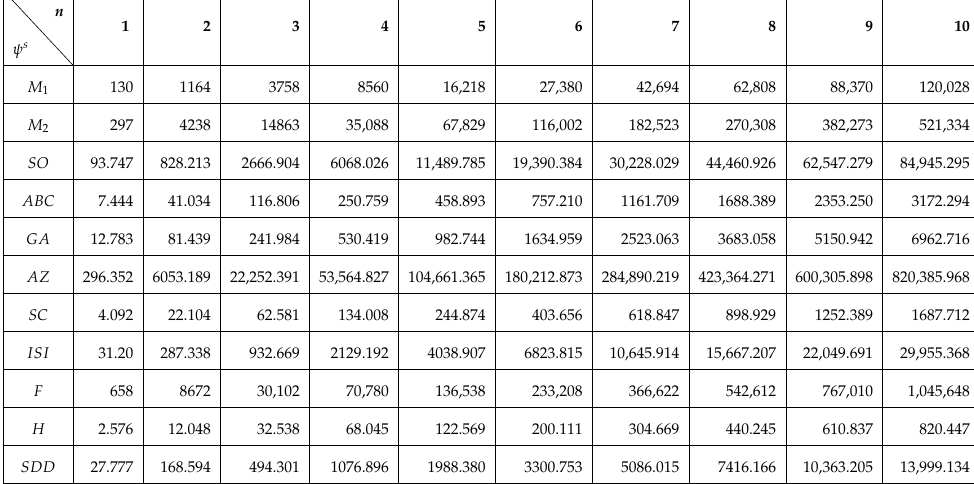
Table 7. Degree-sum descriptors of wave-like nanoribbons WNR ( n , n , n )